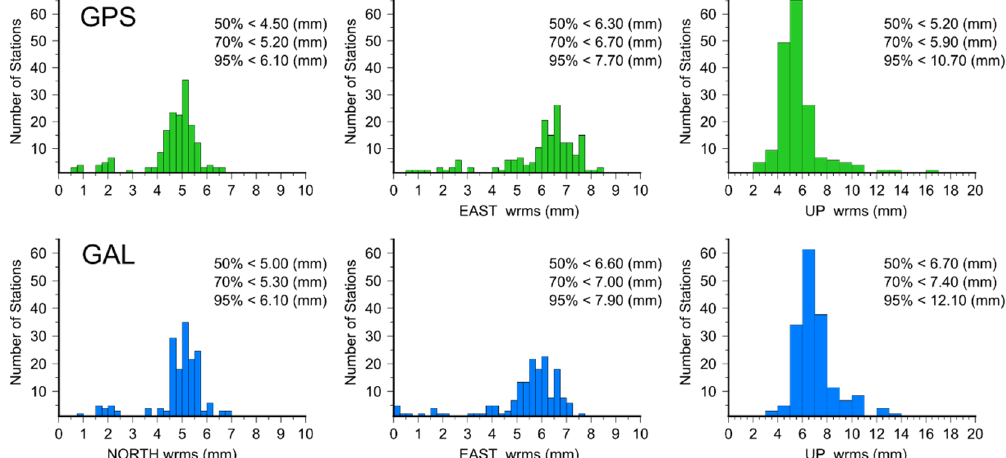
Figure 2. Coordinate repeatability of the GPS and Galileo solutions for the DD approach.